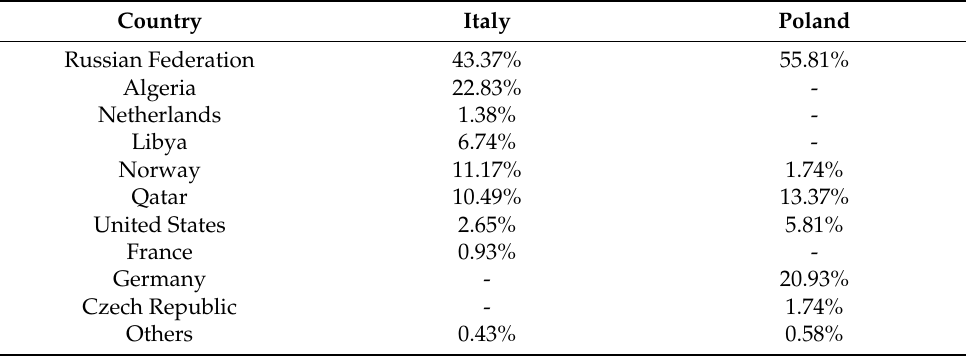
Table 4. Natural gas import shares by origin country for Italy and Poland in